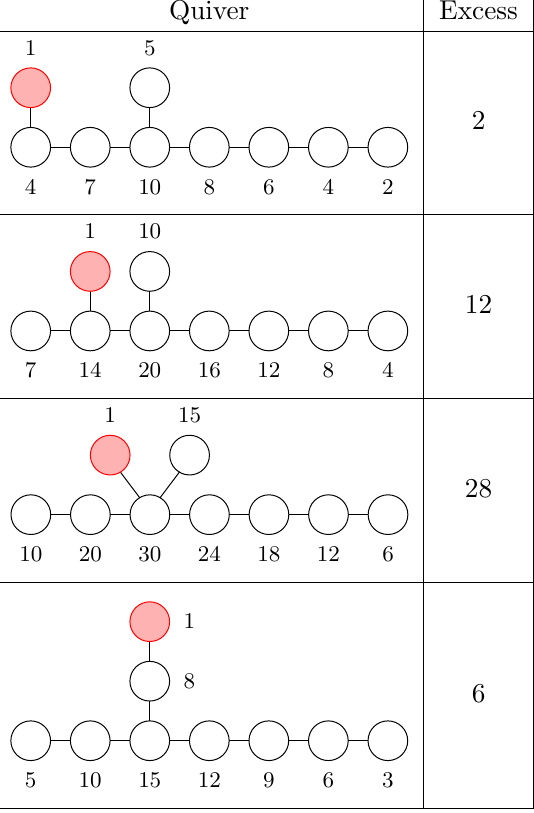
Table 6 . First set of minimally unbalanced quivers with G = E 8